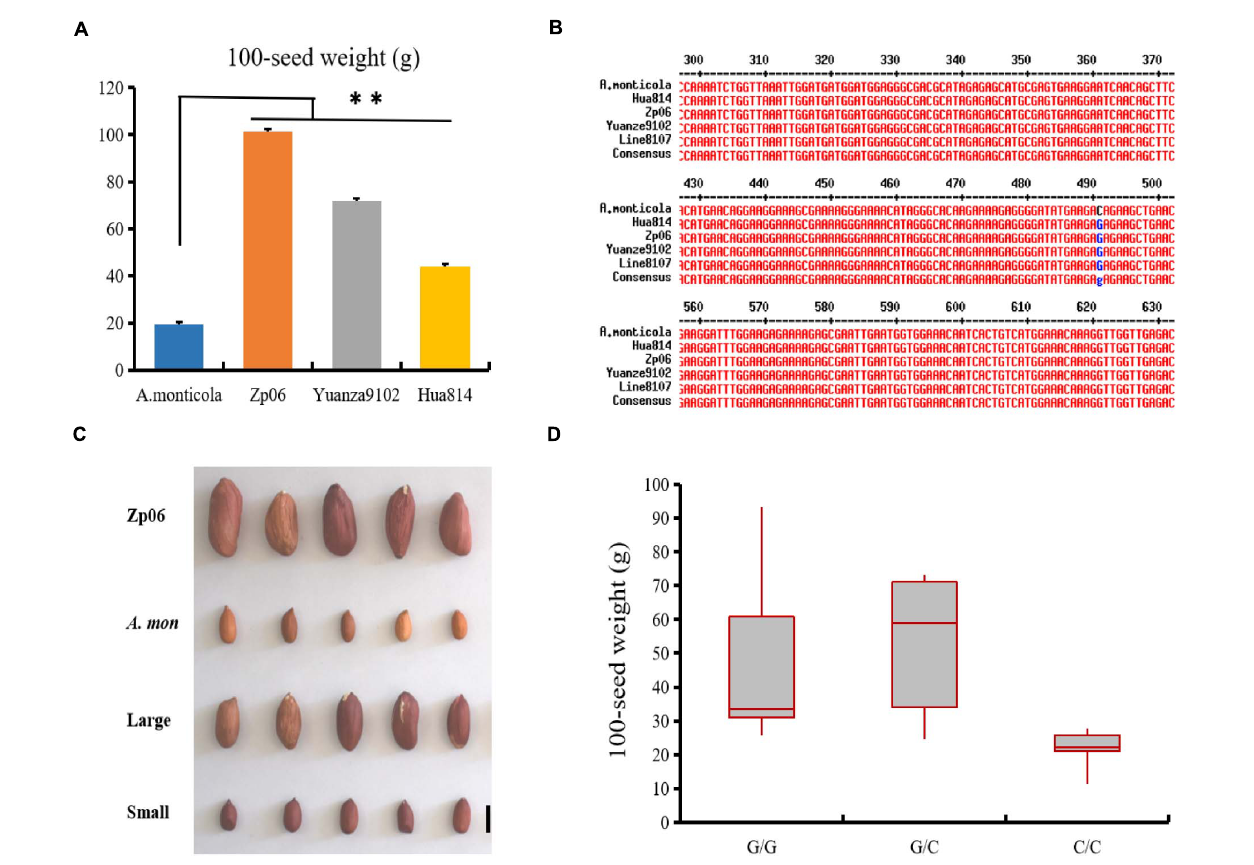
FIGURE 6 | EVM0025654 is associated with increased seed size/weight in cultivated peanut. (A) 100-seed weights for A. monticola and three cultivated peanut accessions. (B) The marker SNP564 was used to genotype these cultivated peanut lines and the SNP locus at position 490 is shown in blue. (C) Seeds of recombinant inbred line (RIL) population (F 6 ) derived from a cross of Zp06 (100-seed weight, 106.2 g) and A. monticola with a 100-seed weight of 19.4 g. Large, some RILs have large seeds; small, others lines have small seeds. (D) Box plot for seed weight of the RILs having G/G, G/C, and C/C genotype at the SNP locus (111201604 bp) in EVM0025654. A Student’s t -test indicated a significant difference ( n = 5 plants) in panel (A) . ∗∗ P < 0.01. All data are given as mean ± SD. Bar = 10